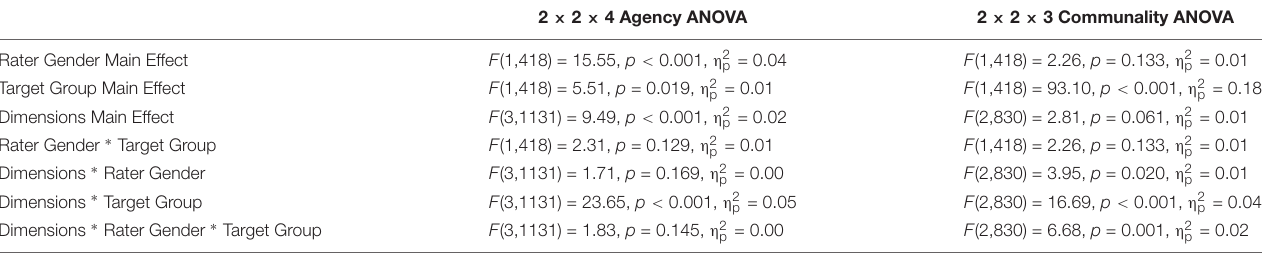
TABLE 3 | Results of 2 × 2 × 4 Agency ANOVA and 2 × 2 × 3 Communality ANOVA for stereotype ratings. 2 × 2 × 4 Agency ANOVA 2 × 2 × 3 Communality ANOVA